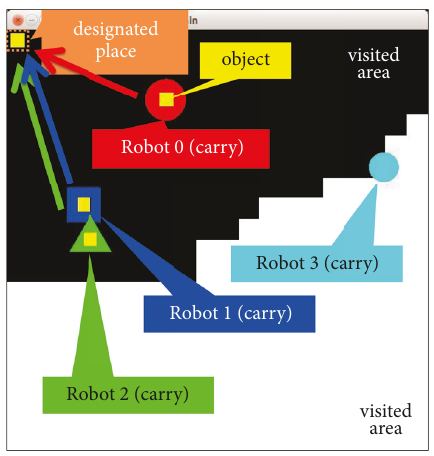
Figure 17: Simulation example: allocate the exploring and carrying tasks to four robots.